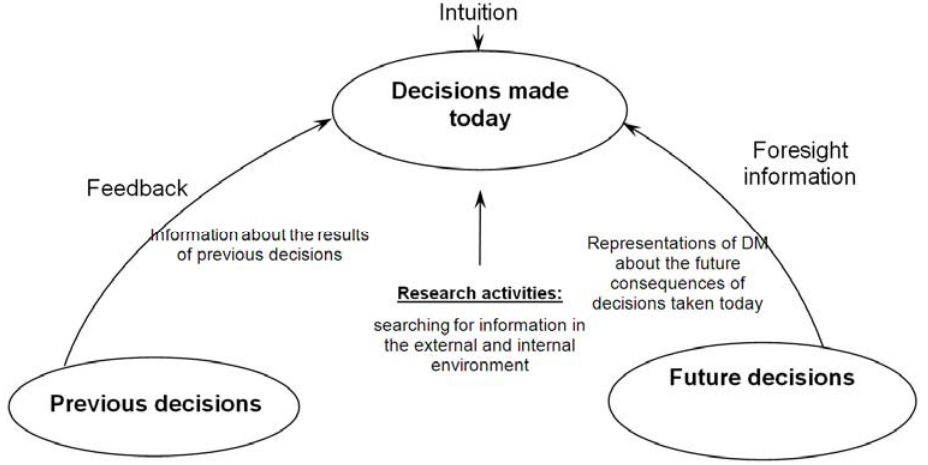
Fig. 1. Information support of preparation and making managerial